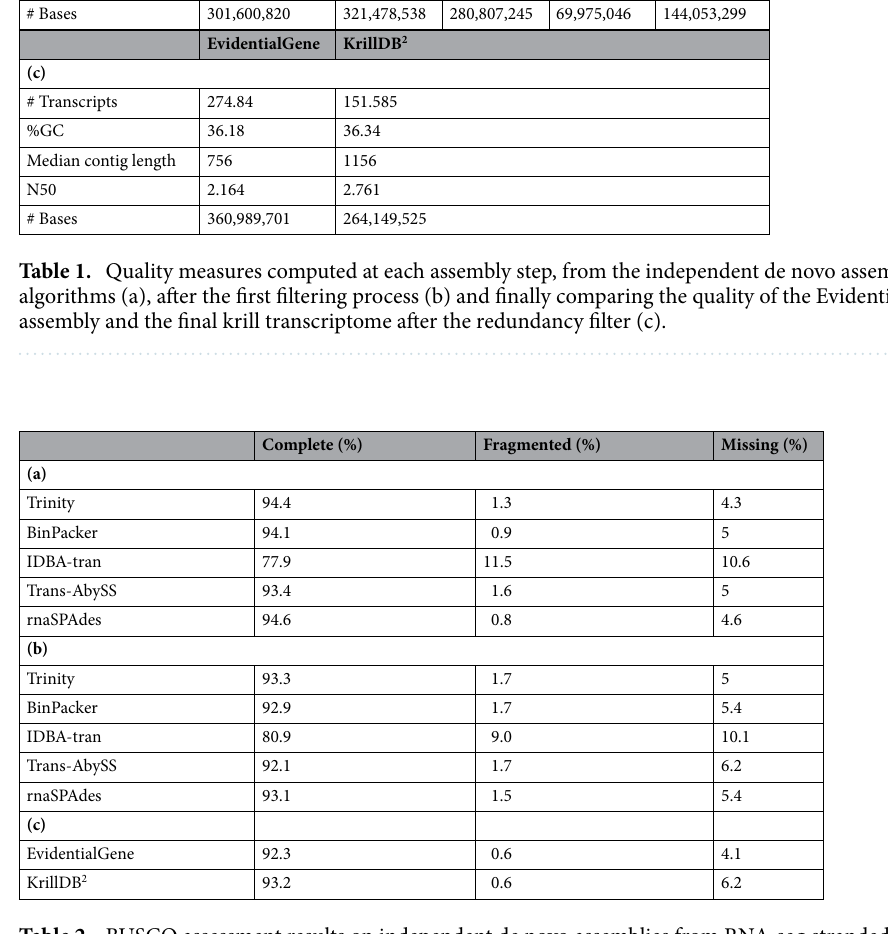
Table 2. BUSCO assessment results on independent de novo assemblies from RNA-seq stranded library. (a), RNA-seq unstranded library (b) and on EvidentialGene transcriptome compared to krill transcriptome after last filter (c): the EvidentialGene transcriptome was characterized by 95.3% Complete sequences, 0.6% Fragmented and 4.1% Missing sequences. The same analysis on the final krill transcriptome reconstruction produced 93.5% Complete transcripts, 0.7% Fragmented and 5.8% Missing sequences.